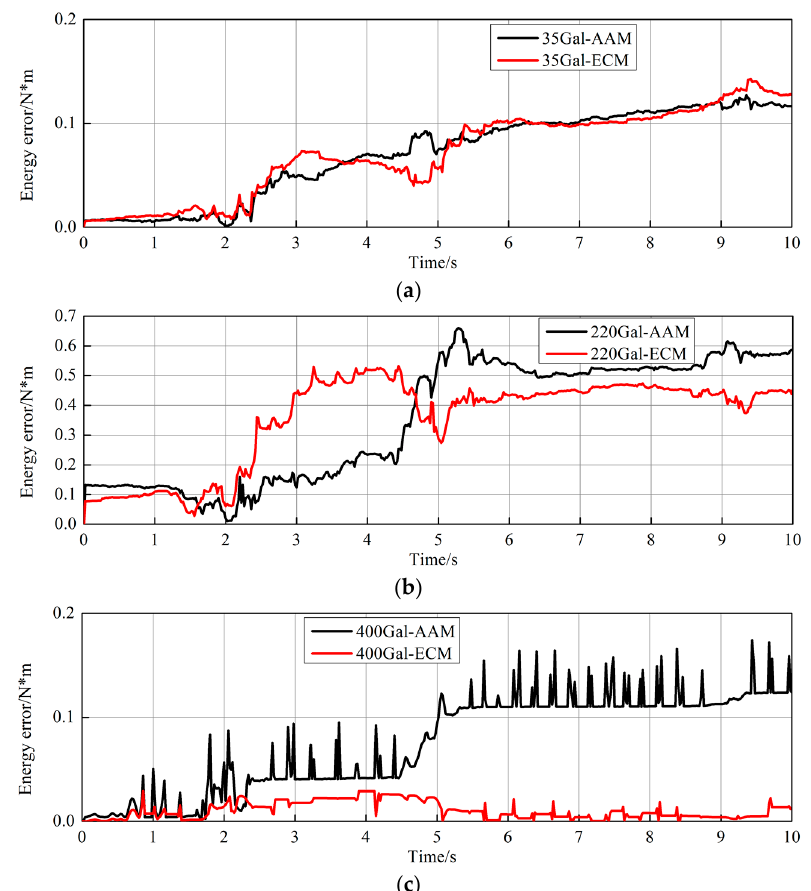
Figure 14. Energy errors of ECM and AAM, ( a ) 35 Gal; ( b ) 220 Gal; ( c ) 400 Gal.